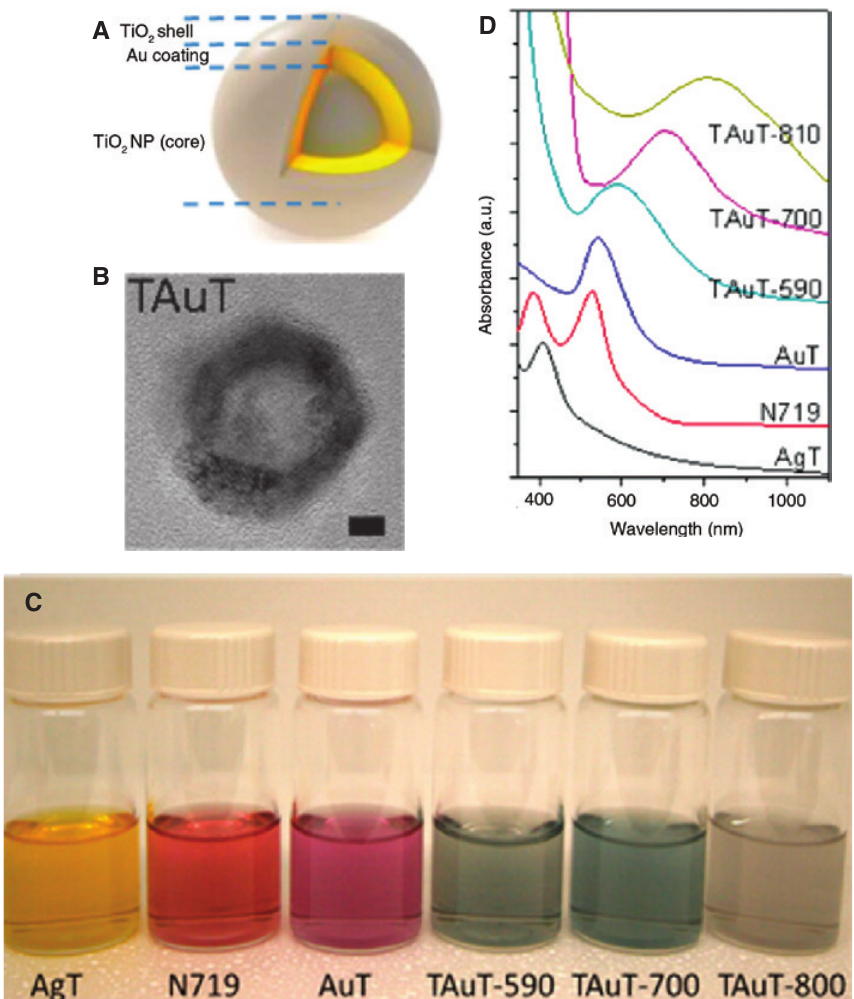
@Au NP@TiO nanostructure, (C) photograph and (D) absorption spectra of 2 2 = 590 nm), TiO , TiO @Au NP@TiO -590 ( λ @Au NP@TiO -700, and TiO @Au NP@TiO -810 in ethanol solu- 2 2 2 LSPR 2 2 2 2